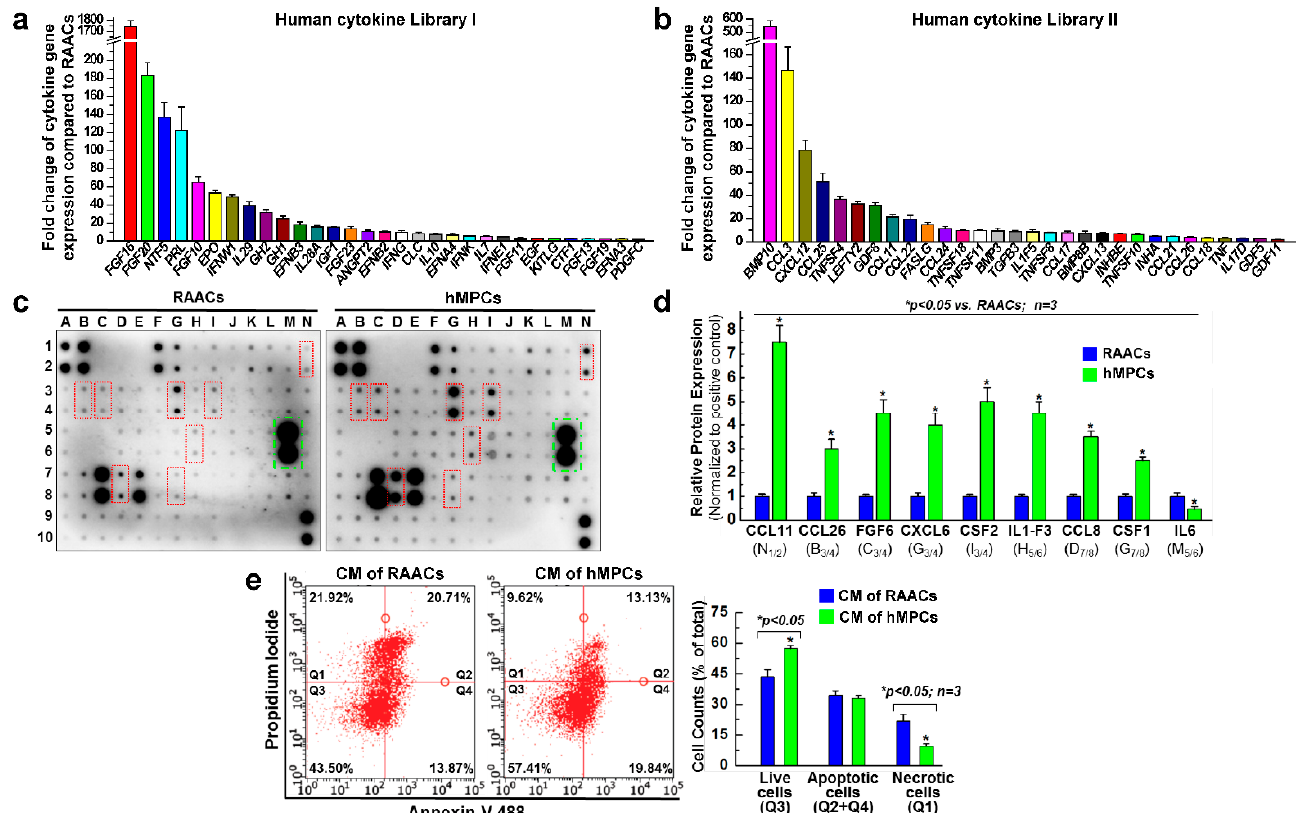
Figure 3. The hMPCs release more cytoprotective and angiogenic cytokines. ( a , b ) The qPCR analysis was conducted using a human cytokine gene array with the human cytokine primer libraries I ( a ) and II ( b ) to evaluate the cytokine gene expression levels in hMPCs versus RAACs. ( c ) Western blotting with human cytokine antibody array was performed to assess the released cytokines in hMPCs and RAACs. ( d ) Quantitative analysis of cytokine protein in hMPCs and RAACs. The y-axis represents fold changes of relative protein expression levels of target cytokines in hMPCs versus RAACs. ( e ) Apoptotic assay with the double staining of Annexin V and propidium iodide (PI) for RAACs that were cultured with conditioned medium (CM) collected from hMPCs and RAACs for 48 h. Quantitative analysis is shown in the right panel. The y-axis represents percentage of cell counts to total cells. Data are means ± SEM. Note: * p < 0.05, unpaired students’ t -test, n = 3 independent experiments.